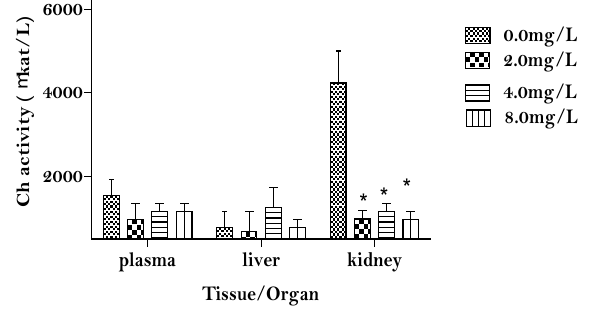
Fig. 4. Cholinesterase activity of Clarias gariepinus exposed to sublethal concentrations of chromium after 7days exposure pe- riod. Symbols as in